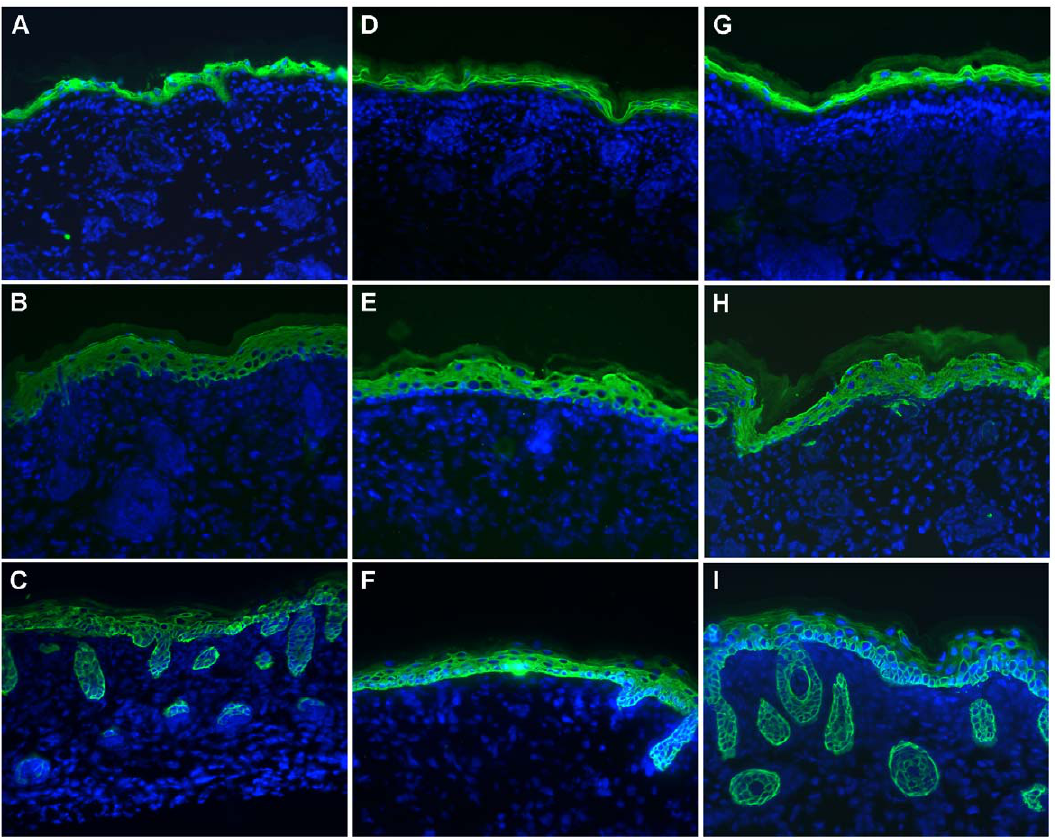
Figure 8. Alterations in Lm-332 expression do not alter skin differentiation. Frozen skin sections of Lamc2 KO (A–C), rescued Lamc2 KO (D– F), and Lamc2 WT (G–I) newborn mice were immunostained for skin differentiation markers loricrin (A, D, G), K10 (B, E, H), and K14 (C, F, I). No significant differences were detected in the staining patterns of these skin differentiation markers in Lamc2 KO, the rescued Lamc2 KO, and Lamc2 WT mice. The epidermis of each of these mice displayed loricrin in the granular layer, K10 in the spinous layer, and K14 in the basal layer.